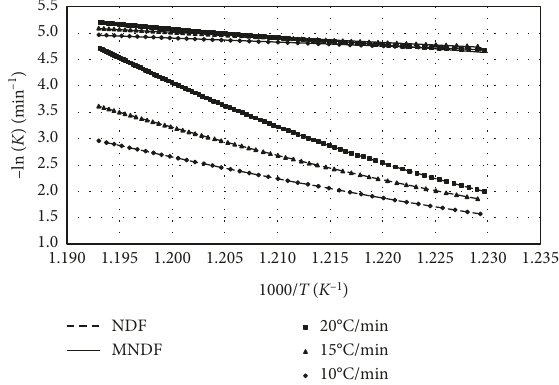
Figure 4: Comparison of Arrhenius plots for MNDF and